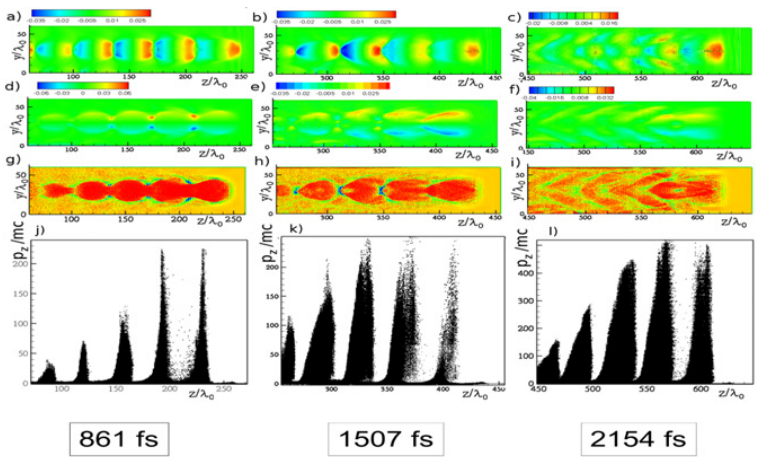
Figure 1. Results from the PIC simulations: contour plots of E z (a, b, c), E y (d, e, f), and electron density (g, h, i) in the y-z plane at three different times: 861fs (left column), 1507 fs (middle column) and 2154fs (right column). In the lowest boxes are shown the longitudinal momentum p z /mc as a function of the longitudinal coordinate